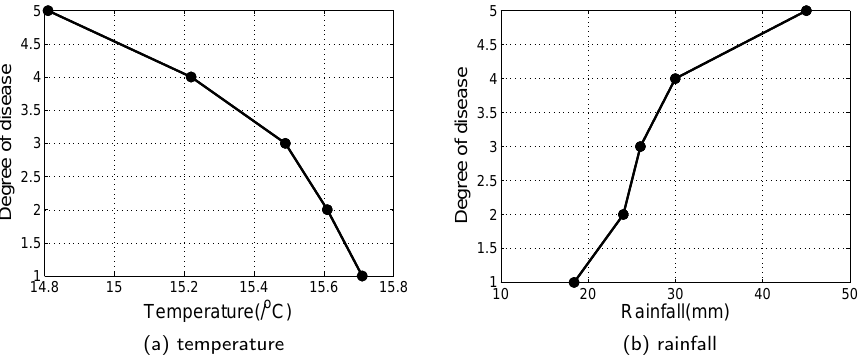
Figure 17. Effect of spring temperature and rainfall on the occurrence of